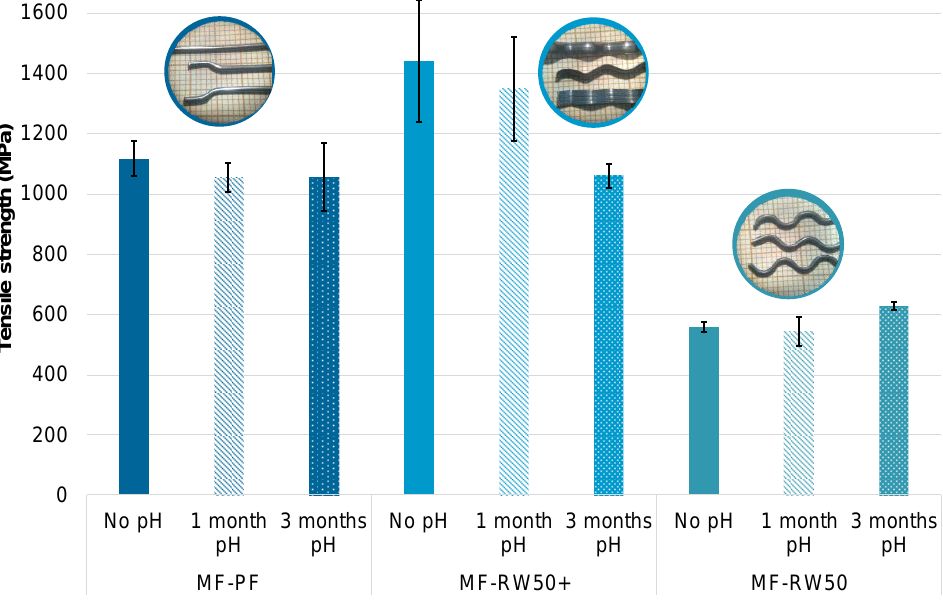
Figure 11. Tensile strength of metal fibers.